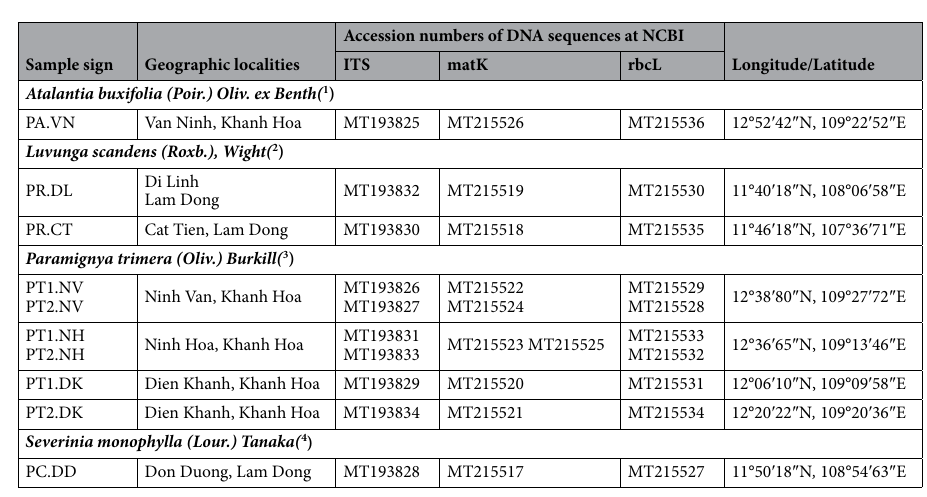
Table 1. List of the collected accessions and information. ( 1 )In our investigation, A. buxifolia (Poir.) Oliv. ex Benth was early described as P. armata var . andamanica King was found in Van Ninh (Khanh Hoa province). ( 2 ) L. scandens (Roxb.), Wight was early described as P. rectispinosa Craib with accepted name A. rectispinosa (Craib) Engl.) ( 3 ) P. trimera (Oliv.) Burkill distributed in different areas in Khanh Hoa province with the